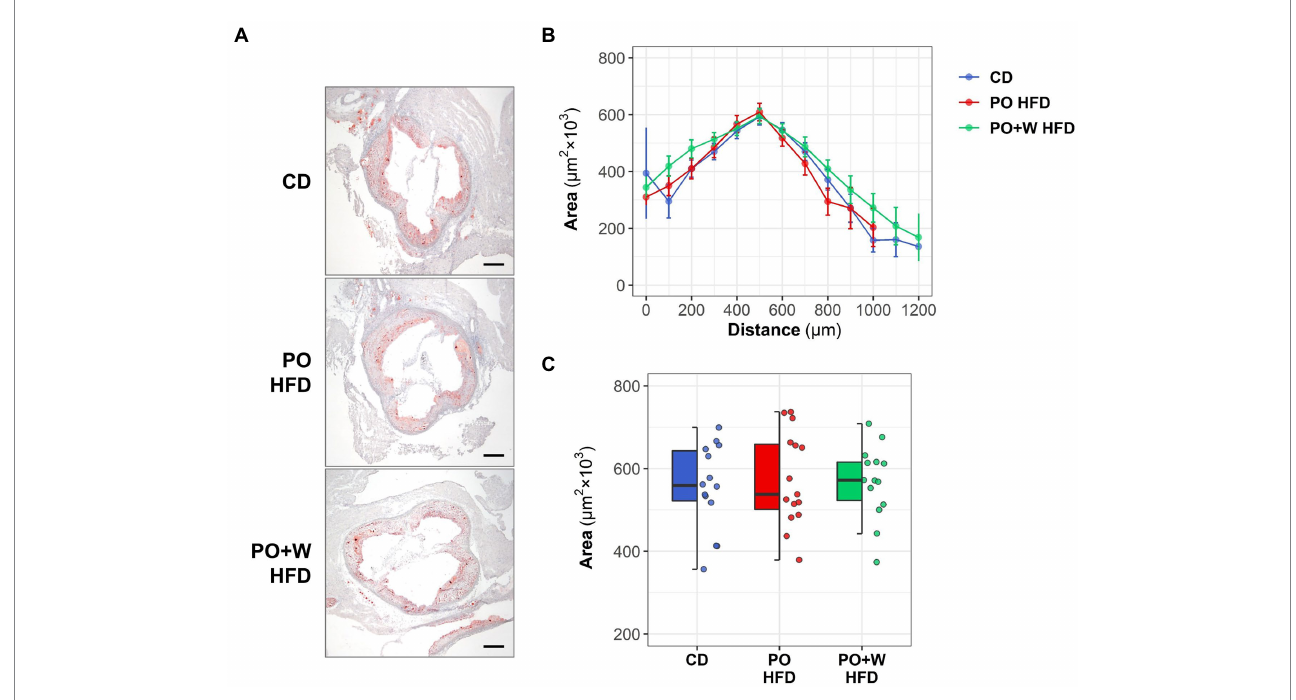
FIGURE 1 Effect of three different diets on atherosclerotic plaque extension and size. Apoe − / − mice received control diet (CD), palm oil-based high-fat diet (PO HFD), or isocaloric palm oil + walnuts high-fat diet (PO + W HFD) diet for 15 weeks. (A) Representative images (magnification x40; scale bars, 200 μ m) of Oil red O/ hematoxylin staining in aortic root sections. (B) Quantification of the extent of atherosclerotic lesions within the aorta (11–13 sections per mice); the line- plot shows results as mean ± SEM. (C) Mean maximal lesion area in each group of intervention (2–3 sections per mice); dot and box plot shows individual values and depicts the median (horizontal bar), interquartile range (IQR, hinges) and 1.5 × IQR (whiskers). CD, control diet ( n = 14); PO HFD, palm oil-based high-fat diet ( n = 15); and PO + W HFD, palm oil + walnuts high-fat diet (isocaloric inclusion of 3% of walnuts at expense of palm oil, n =